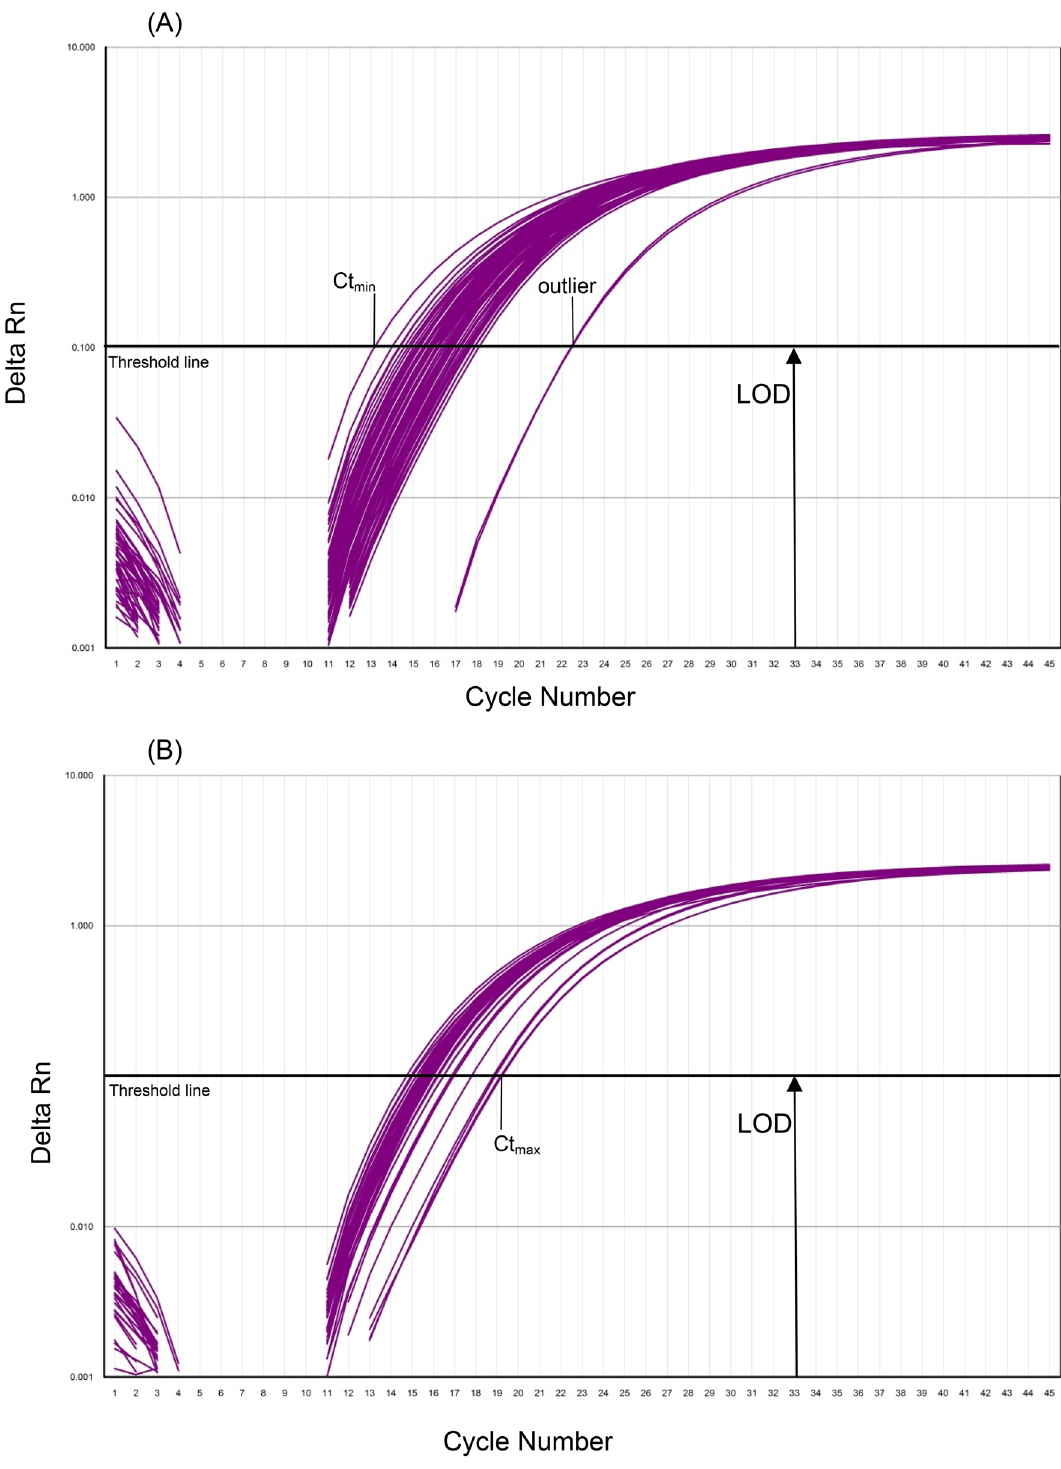
Figure 1. Intraspecific variability of hemp varieties with the numbers 1 and 21–101 ( A ) and with the numbers 4–20 and 107–128 ( B ) according to Table 1, obtained with 5 ng/µl DNA per tube. Results of Grubbs outlier and Shapiro-Wilks test ( C